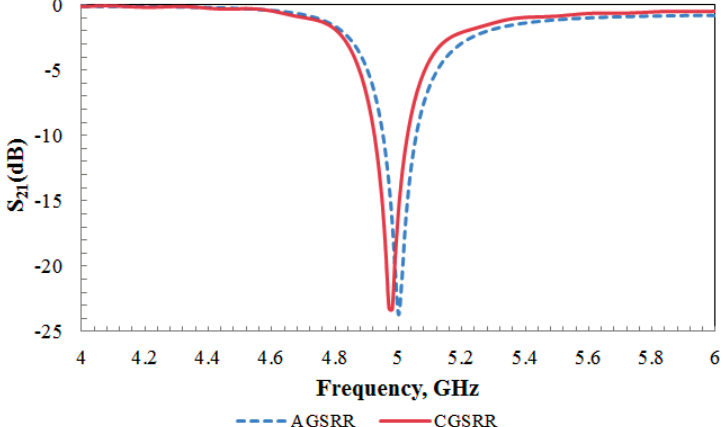
Figure 3. Simulated S-parameter for the aligned-gap MSRR and centered-gap